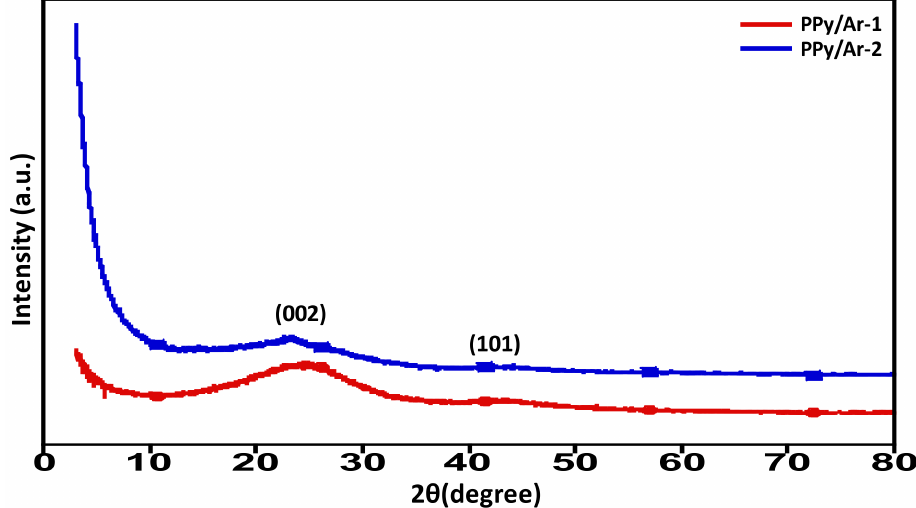
Figure 7. XRD diffractograms obtained for N-GOs PPy/Ar-1 and